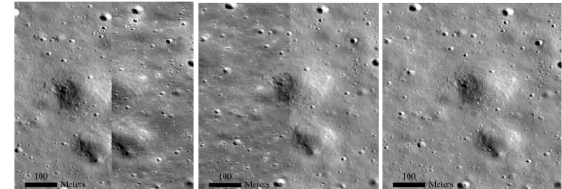
Figure 4. Comparison of the seams between the DOMs of neighboring NAC images before (left) and after (middle and right) planar block adjustment. The right figure shows result of further radiometric correction based on histogram matching.